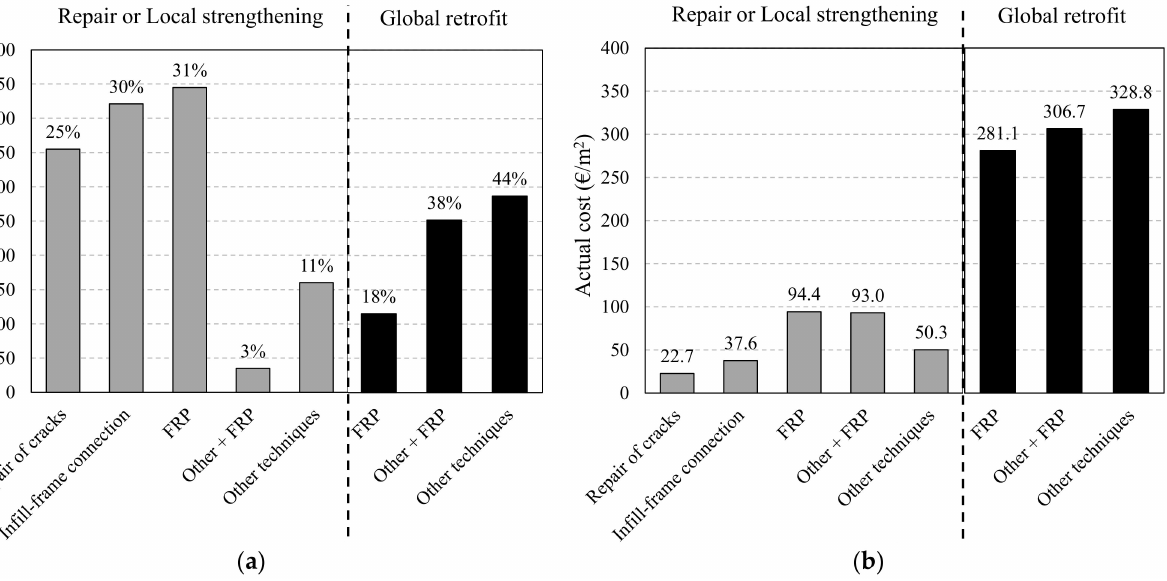
Figure 2. Distribution of strengthening interventions ( a ) and actual costs ( b ) for buildings subjected to repair or local strengthening (1416 buildings) or to a global retrofitting (454